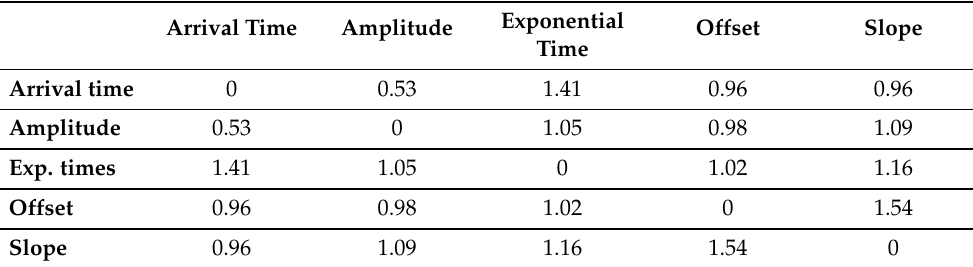
Table 4. Correlation distance C D between fitted